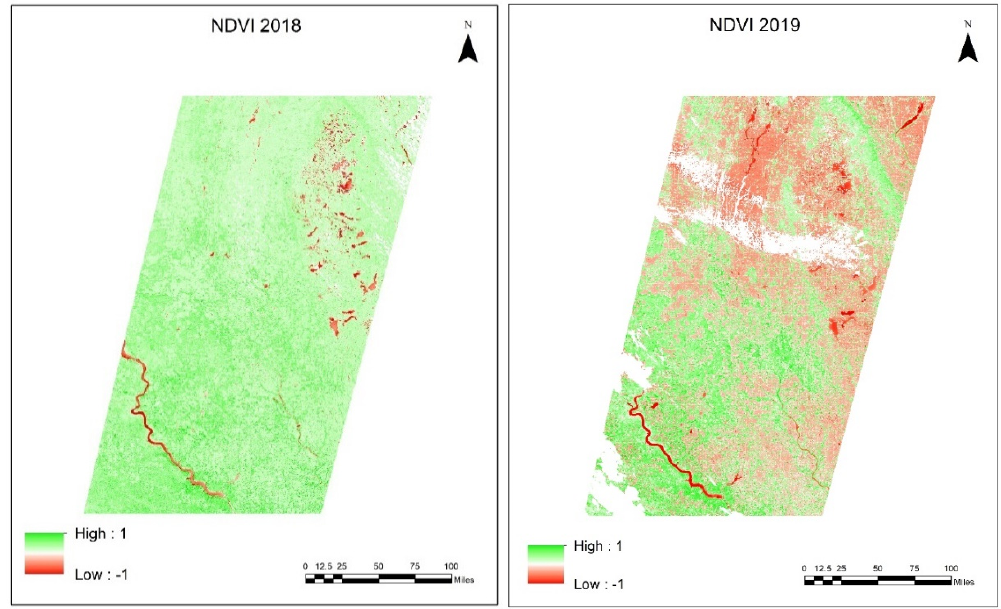
Figure 3. The 2019 image shows lower NDVI values compared to the previous year which could be an indication of flooding. Gaps (white pixels) in the images are due to masked clouds.